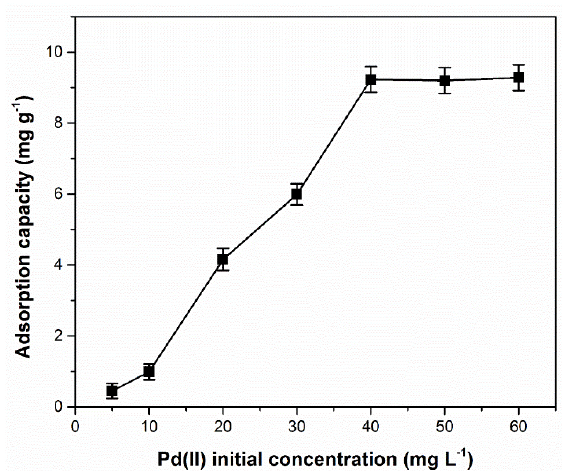
Figure 6. Influence of Pd(II) initial solution concentration on adsorption capacity of MgSiO 3 -cys.